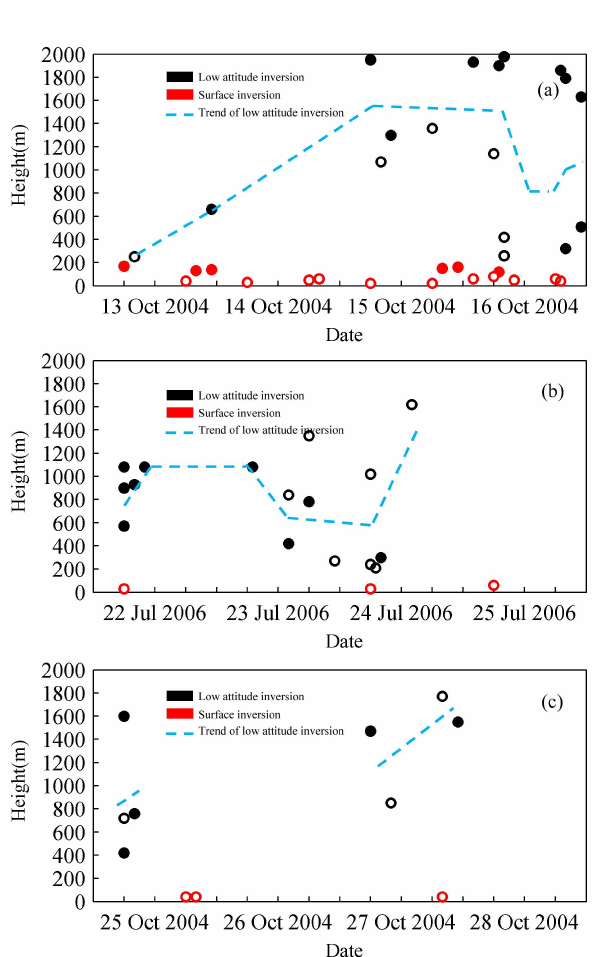
Fig. 10. Time series for inversion layer height at the Panyu sta- tion (a) from 13 to 16 October 2004, (b) 22 to 25 July 2006, and (c) 25 to 28 October 2004. (Solid circles: thickness of inversion layer ≥ 100m; Open circles: thickness of inversion layer